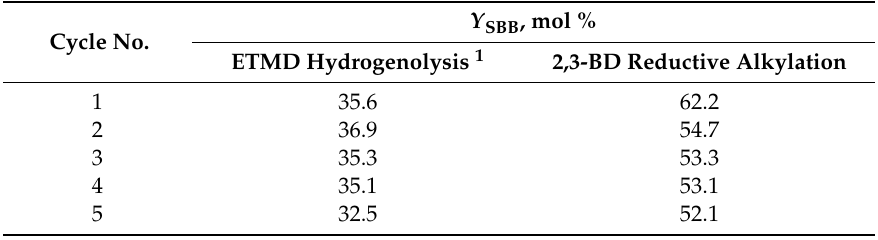
Table 6. The synthesis of SBB over 2% wt. Pd / Al-HMS (15): the catalyst reusability test. The conditions are: p(H 2 ) = 40 bar, 100 mg of the catalyst, 2.5 mL of the ketal, the reaction time was 5 h. Cycle No.